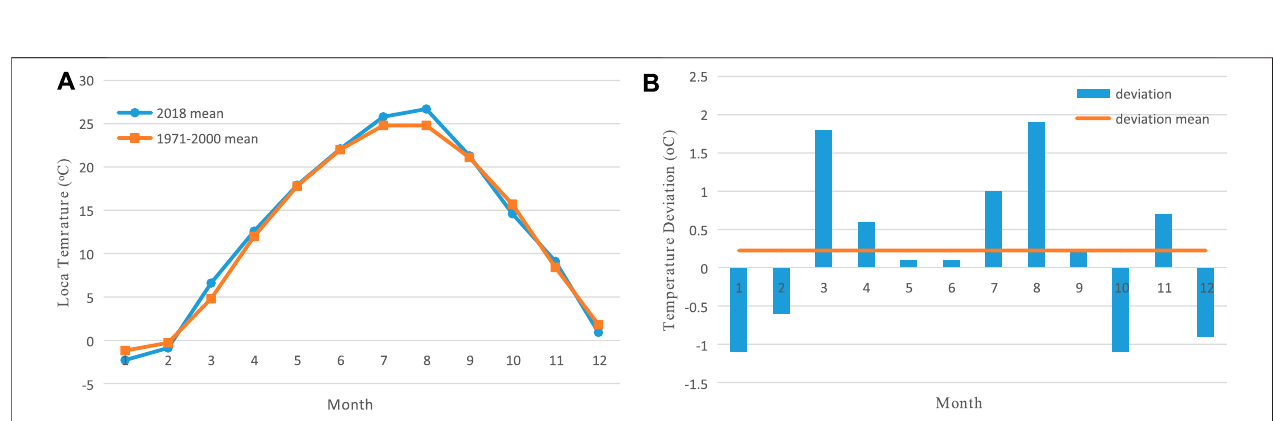
FIGURE 8 | Monthly temperature in Yantai City, China: (A) comparison between the average in 2018 and the average of multi-year series (1971 – 2000) and (B) comparison deviation.